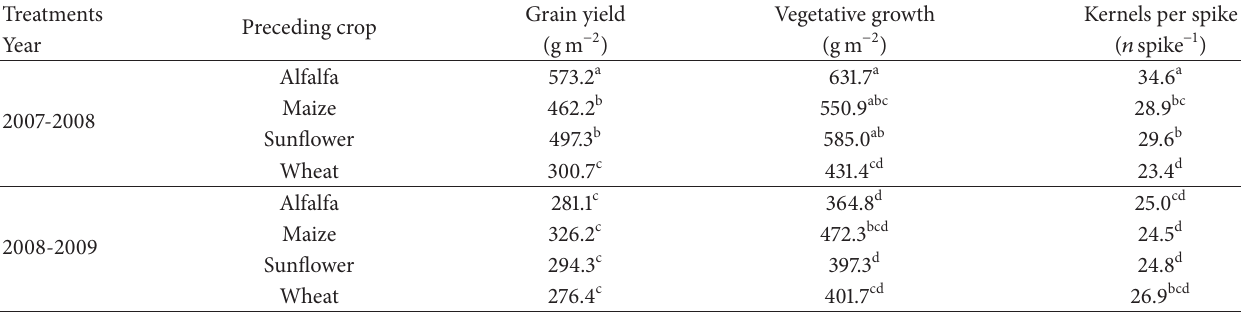
Within columns, numbers followed by the same letter are not significantly different at 𝑃 ≤ 0.05. Table 4: Mean values of spike number, mean kernel weight, spike fertility index, and spikelet number per spike as affected by year, preceding crop, and variety.